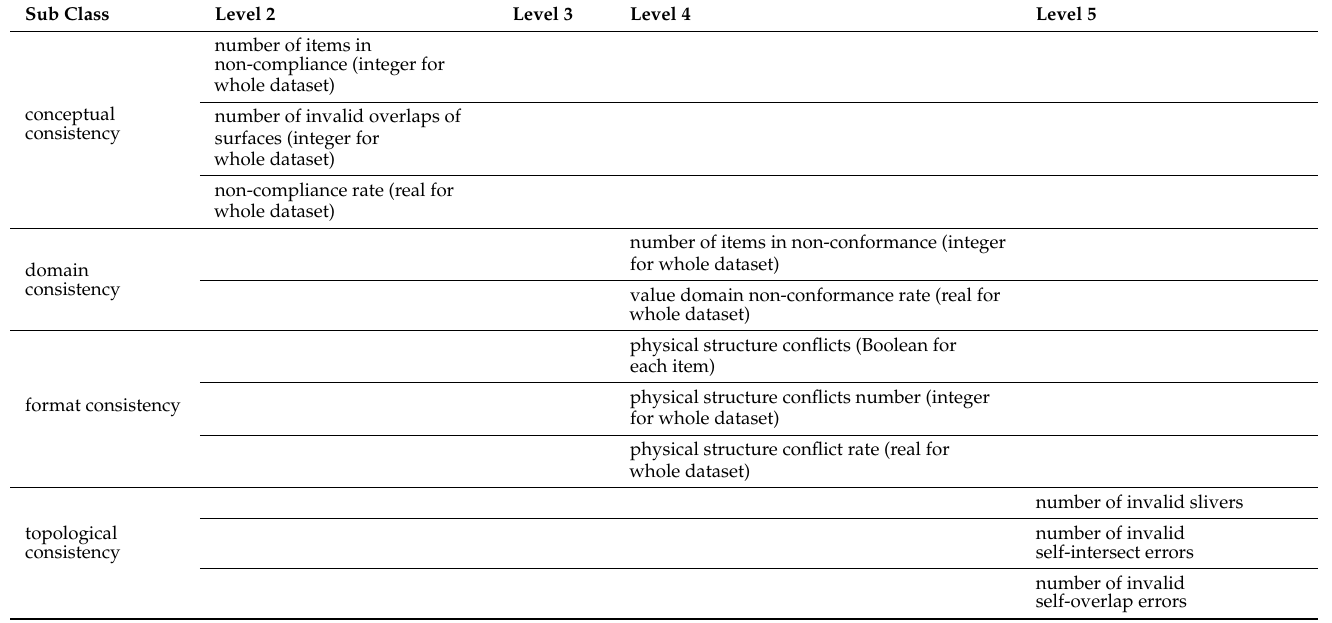
Table A6. Spatial data quality matrix for class logical